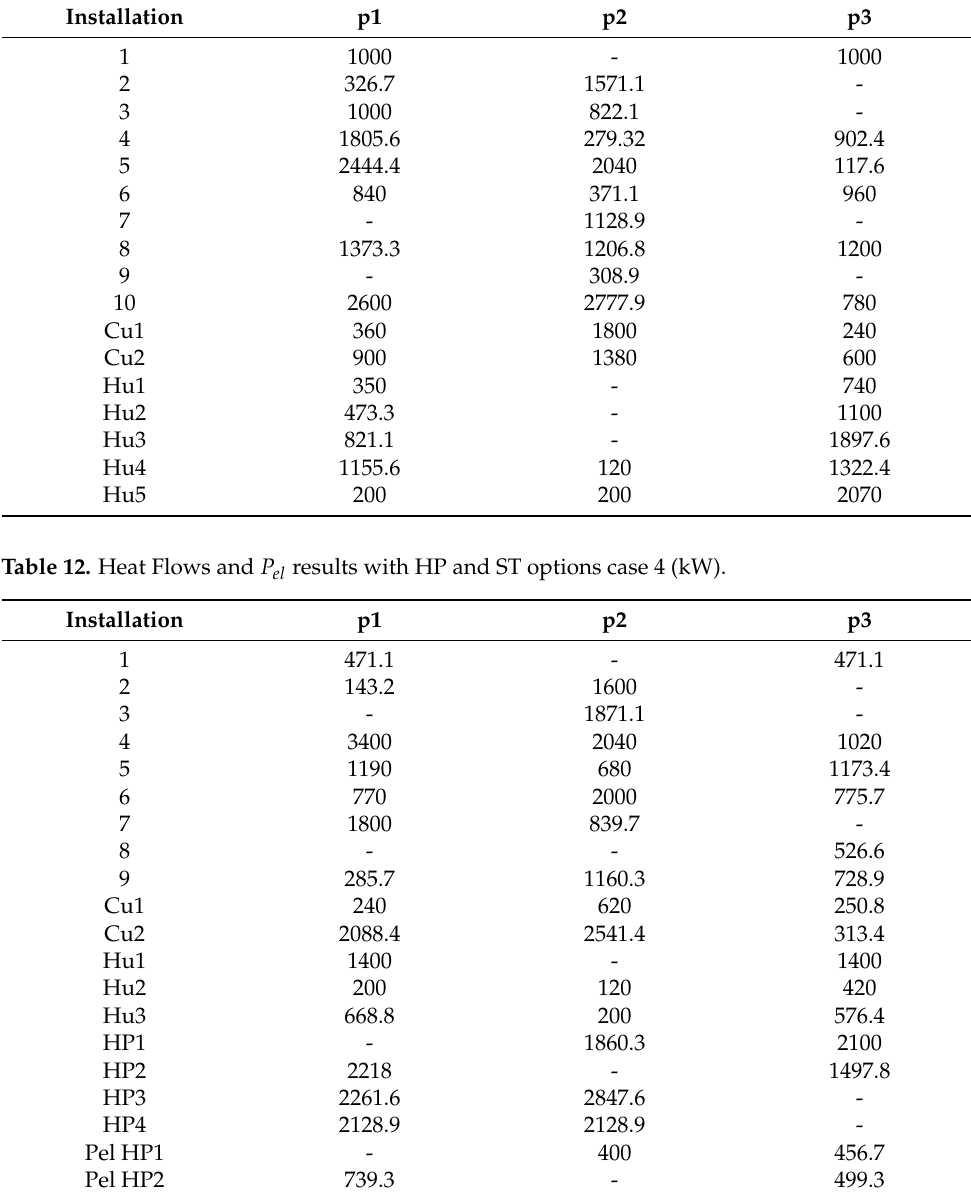
Table 11. Heat Flows without HP and ST case 4 (kW).